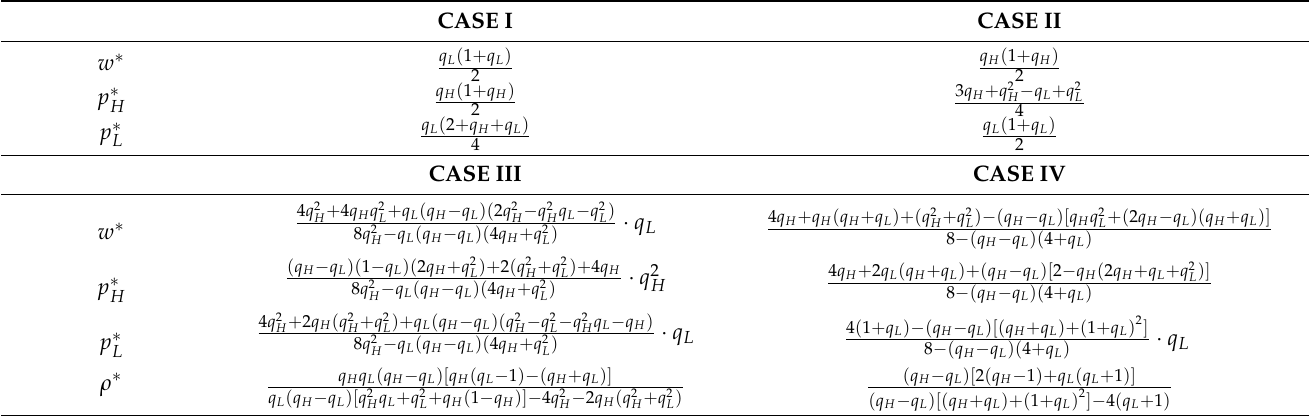
Table 1. Optimal solutions for the wholesale selling prices for products with variations in the quality and promotional